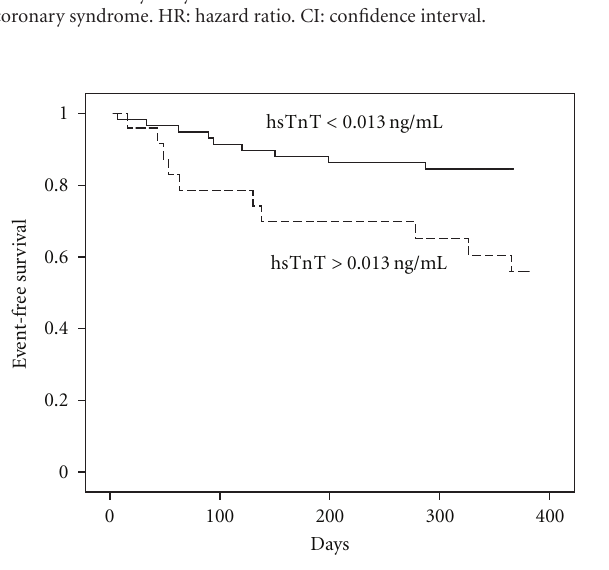
Figure 2: Kaplan-Meier curve showing the e ff ects of hsTnT levels on adverse events following in non-STEACS patients. Patients with raised hs TnT levels, had a significant worse outcome compared with patients with lower hsTnT levels at 12-month followup (cuto ff point > 0.0013 ng/mL; log-rank test, P = 0 .